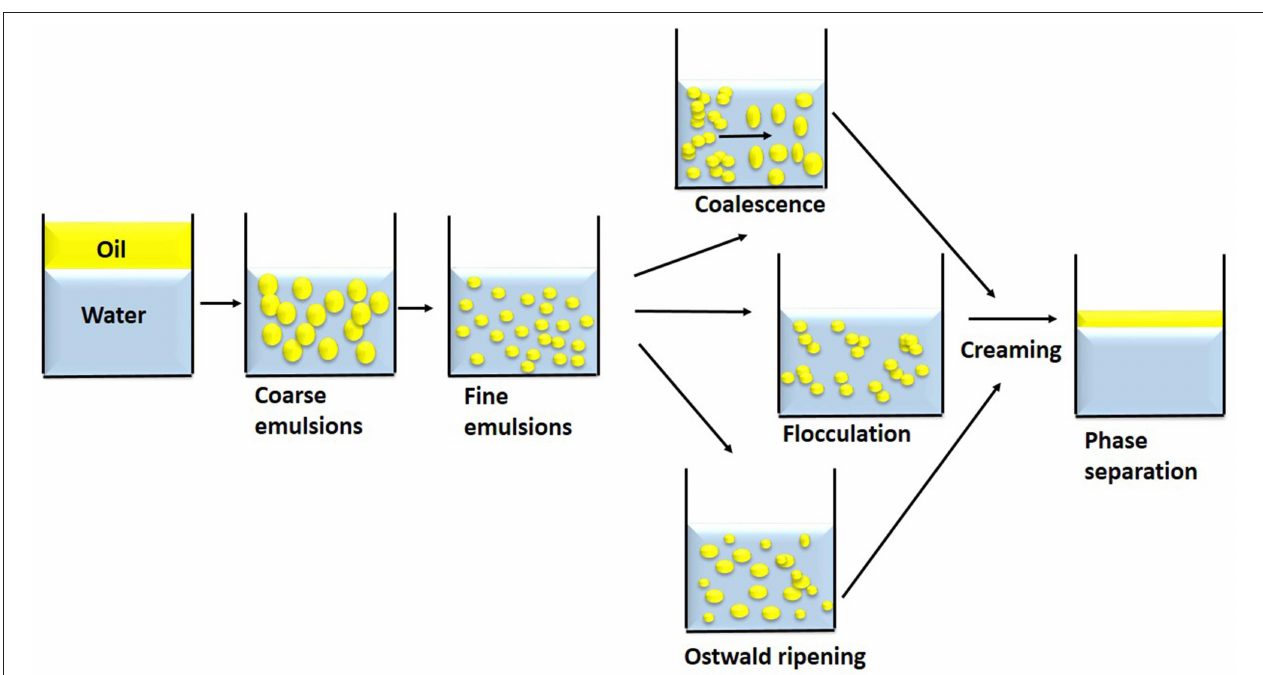
FIGURE 1 | Nanoemulsion formation and destabilizing mechanisms. Coalescence involves droplets combining; flocculation involves droplet aggregating but do not combine; droplets grow in size through Ostwald ripening. This destabilizing mechanism results in creaming and phase